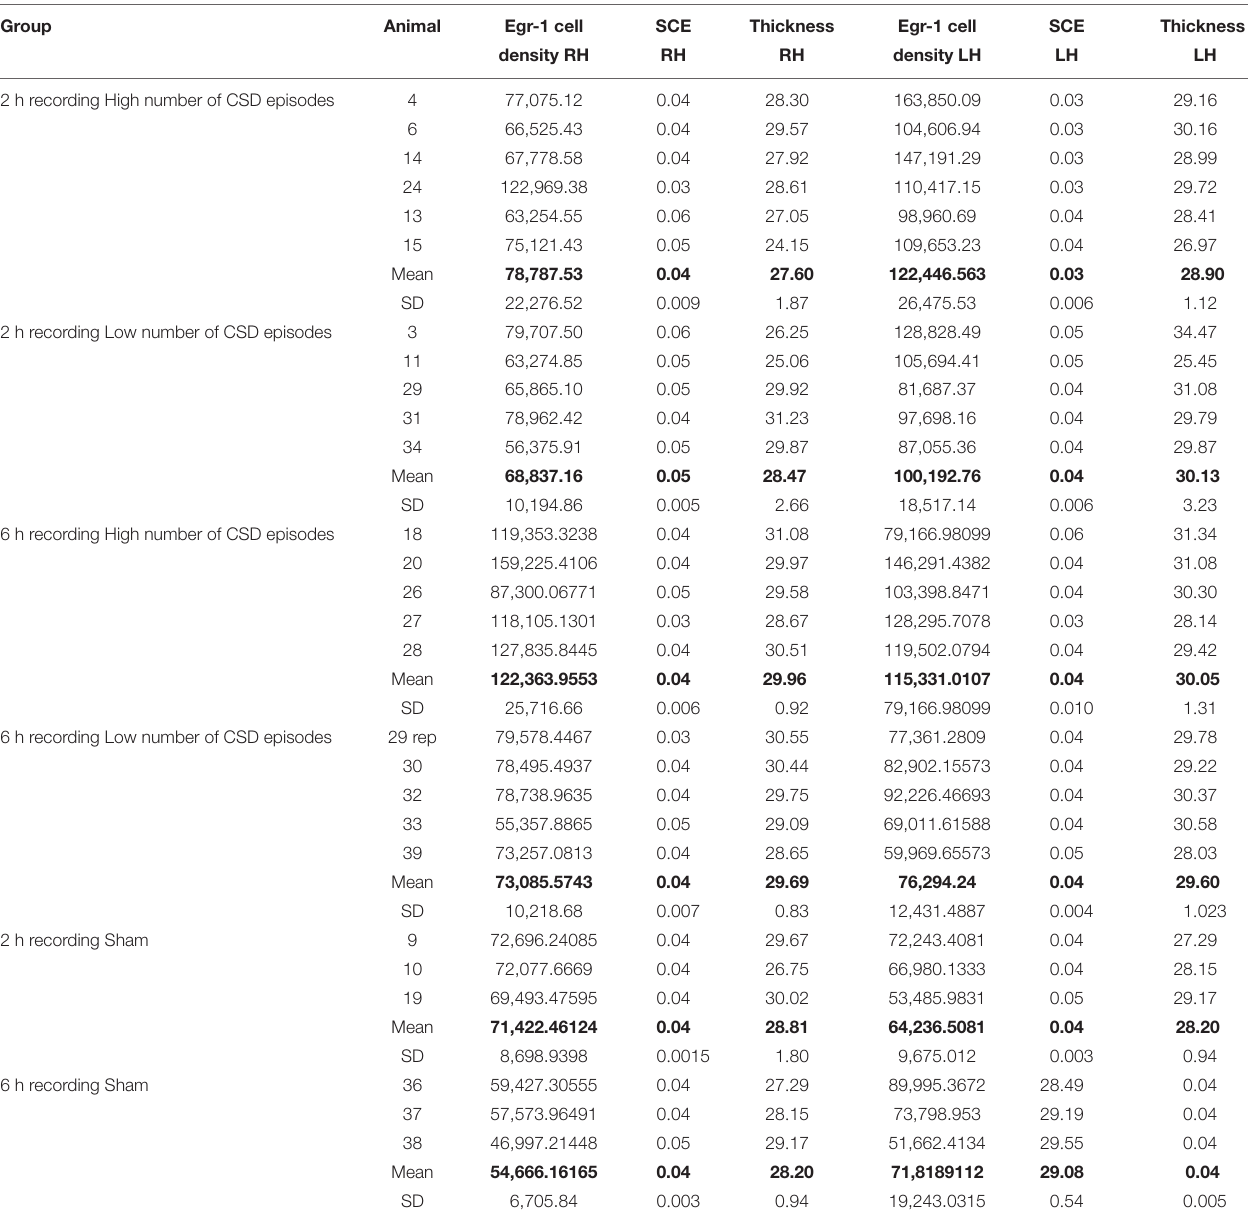
TABLE 2 | Stereological determination of Egr-1–positive cell density on the left and right hemispheres at the infragranular layers of the somatosensorial cortex for 2 and 6 h of recording of the induction of cortical spreading depression (CSD) in adult rats. Group Animal Egr-1 cell SCE Thickness Egr-1 cell SCE Thickness density RH RH RH density LH LH